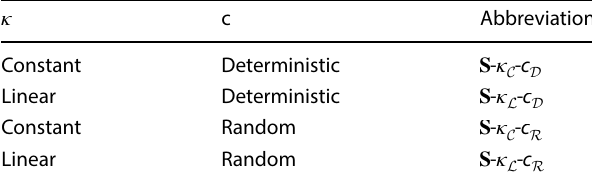
Table 3 Non-porous (solid) analyses performed